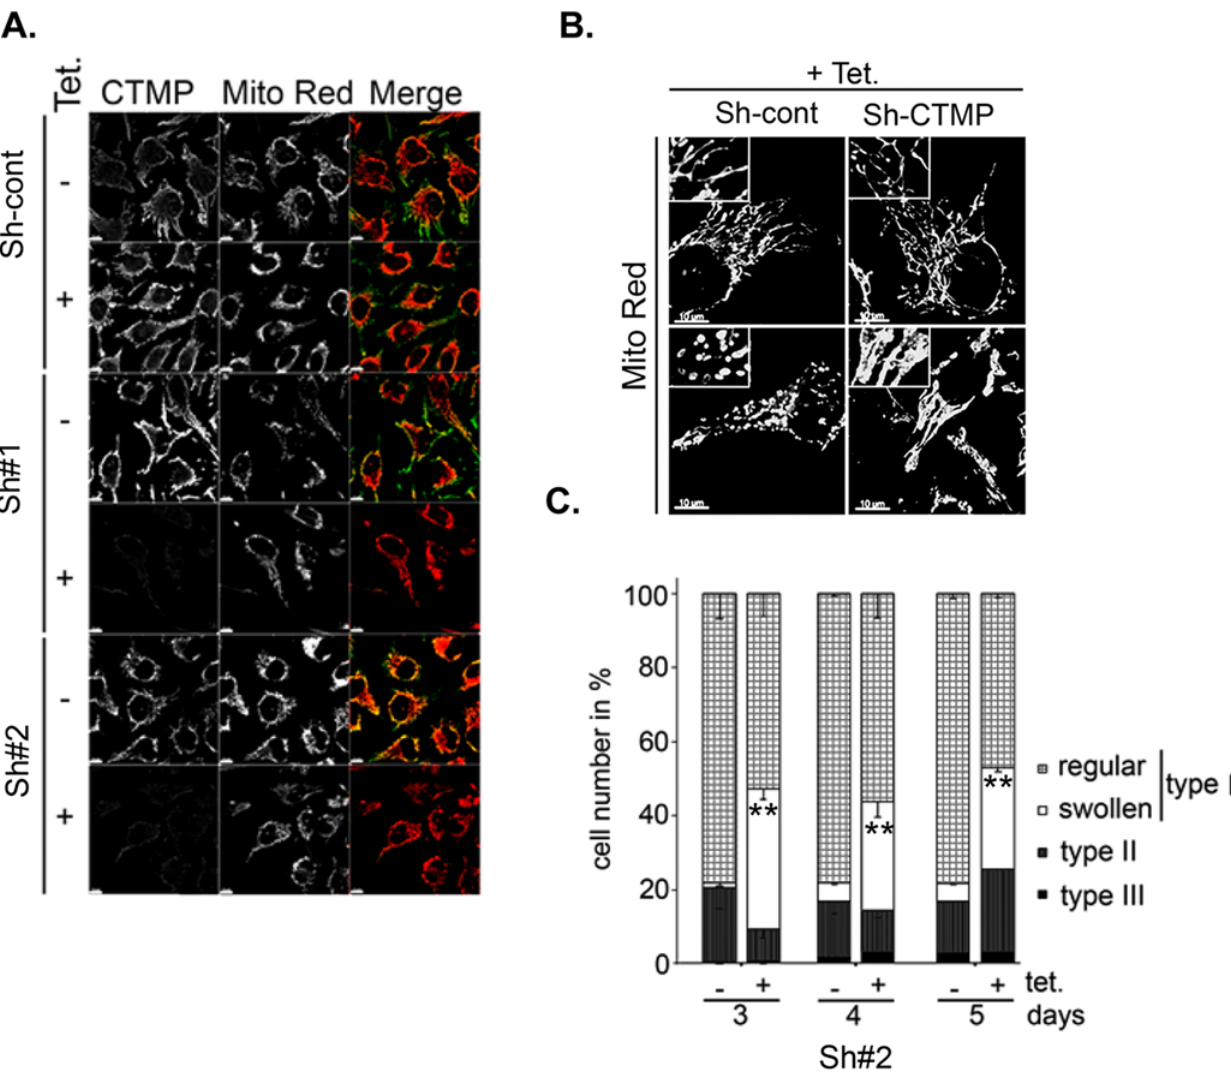
Figure 3. CTMP expression affects mitochondrial network organization. (A) Confocal microscopy of CTMP expression in tetracycline inducible HeLa clones stably expressing pTer plasmid coding for a control short hairpin (Sh-cont) or a short hairpin directed against CTMP (Sh # 1 and Sh # 2). Cells were visualized by immunofluorescence after 5 days culture in the presence or absence of tetracycline (2 m g/mL), together with the MitoTracker Red. (B) Representative confocal pictures of mitochondrial shape in tetracycline-inducible HeLa clones cultured 5 days in the presence of tetracycline. Mitochondria were visualized with MitoTracker Red. (C) Morphological analysis of mitochondria shape in HeLa Tet-on clones treated as in (A) for 3, 4 or 5 days. For each experiment, at least 200 cells were counted in three distinct fields. Data are means 6 SEM, n =2. The differences in mean values are statistically significant (Sh # 2 minus tetracycline compared to Sh # 2 plus tetracycline) as determined by 1-way ANOVA; ** P # 0.001.